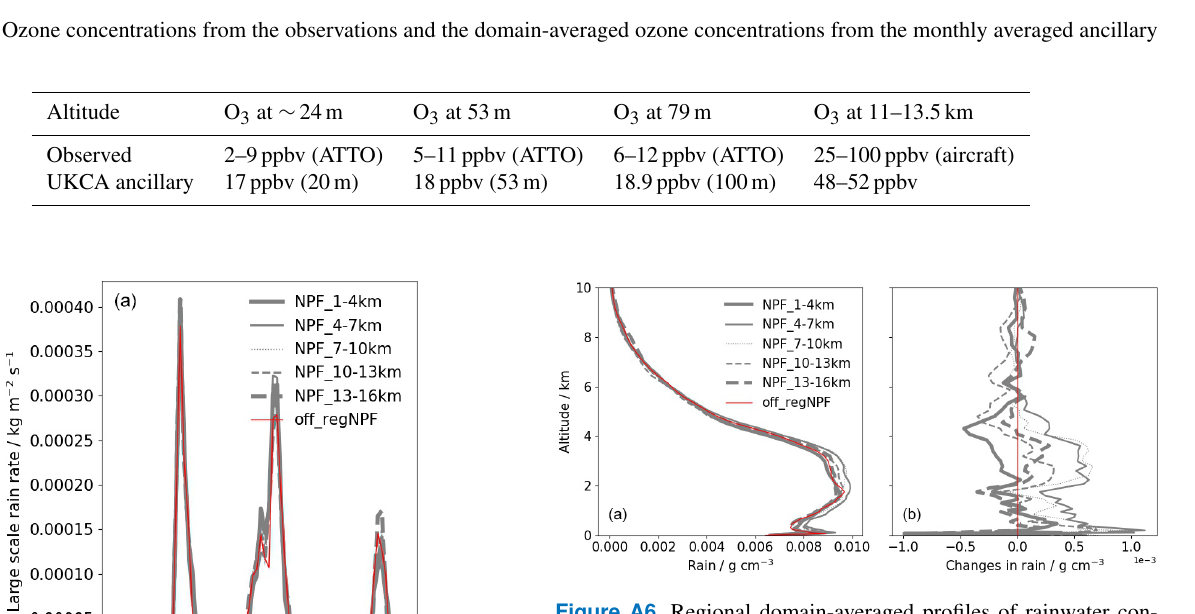
Figure A6. Regional domain-averaged profiles of rainwater con- tent in the simulations NPF_1-4km, NPF_4-7km,